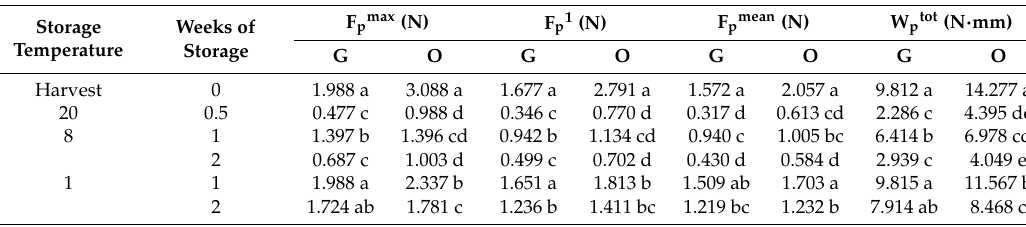
Figure 6. PCA performed on force/displacement curves issued from puncture tests of the flesh of ( a , b ) ‘Goldrich’ and ( c , d ) ‘Orangered ® ’ apricots at harvest and after 0.5 week at 20 °C (T20_0.5), 1 and 2 weeks at 1 °C and 8 °C (T8_1, T8_2, T1_1 and T1_2). ( a , c ): PCA scores, ( b , d ): PCs loadings. Table 7. Influence of storage temperature and duration on F pmax , F p1 , F pmean and W ptot . Means with the same letters in a column are not significantly different at p ≤ 0.05 in Fisher’s multiple range test. G: ‘Goldrich’ and O: ‘Orangered ® .